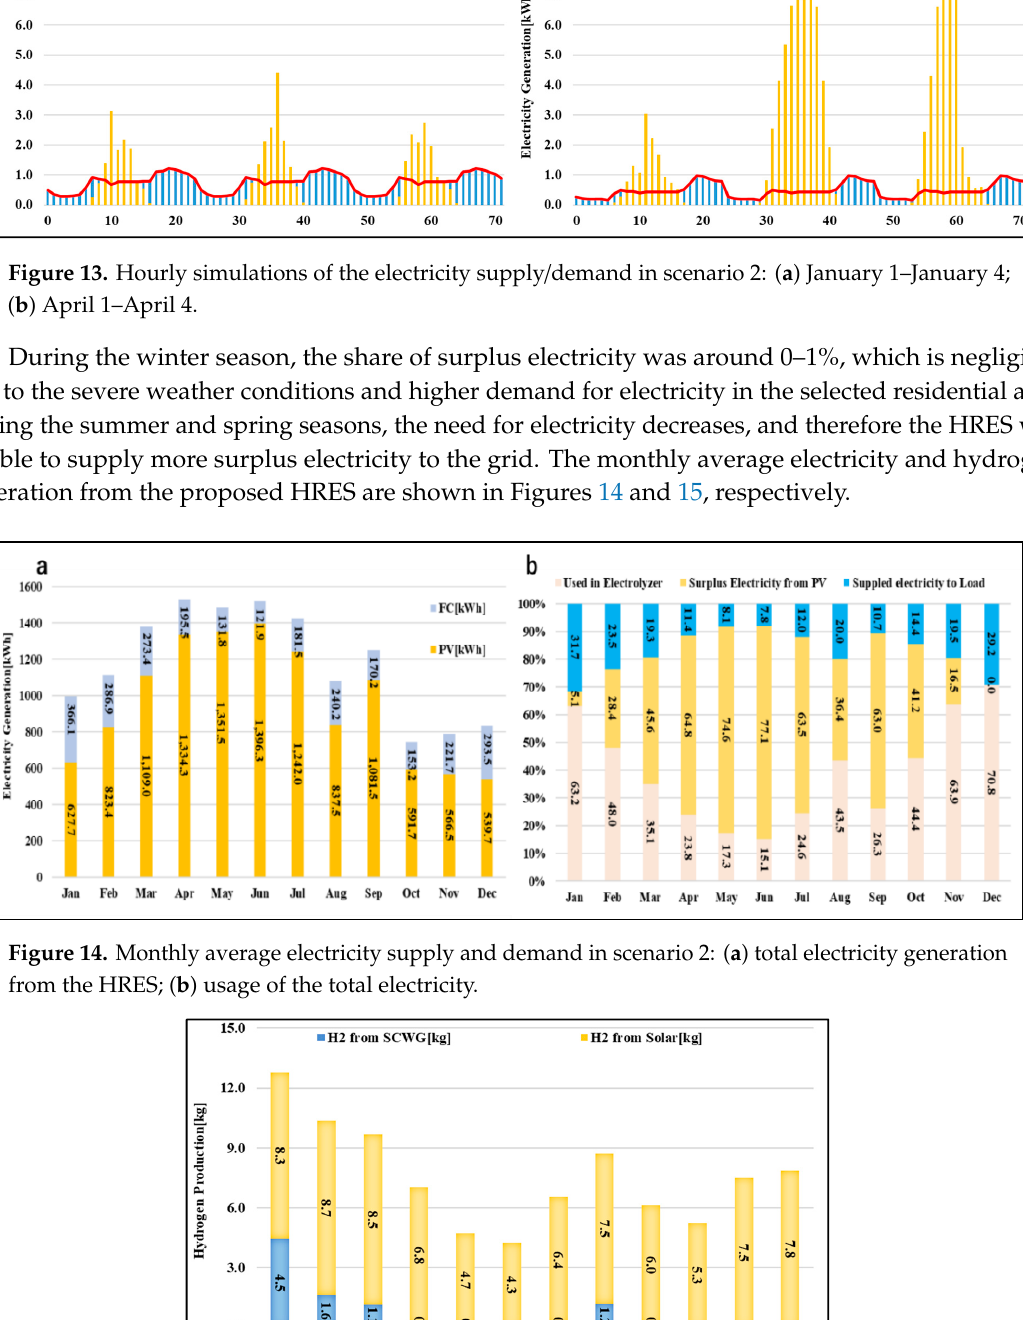
Figure 15. Monthly average hydrogen production in scenario 2.